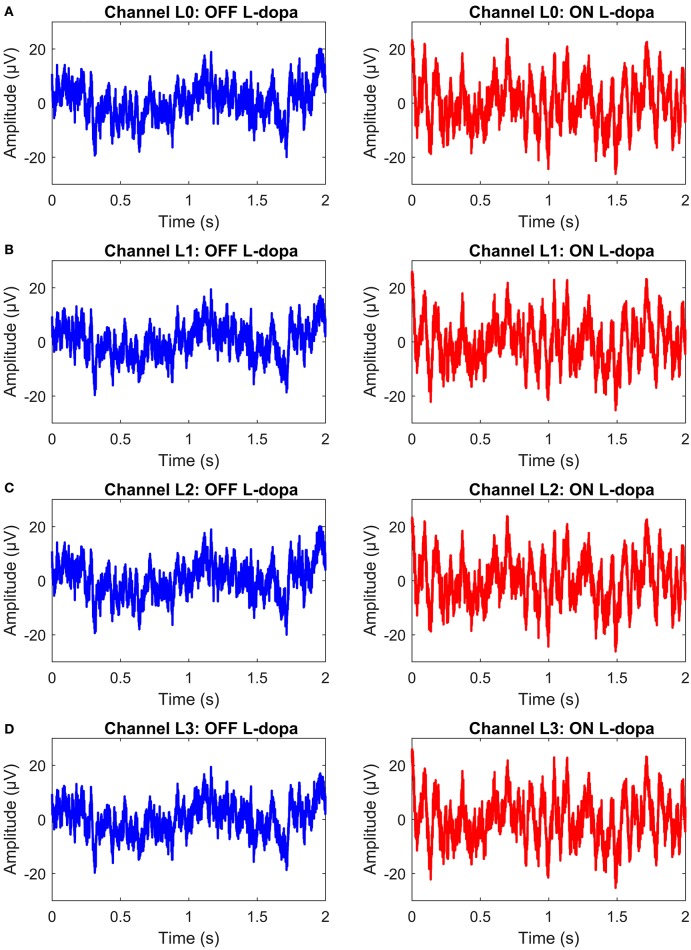
A snapshot of OFF and ON L-dopa recordings (representing PD and non-PD LFP recordings) of the left DBS lead of dataset A. (A) OFF and ON L-dopa recordings of electrode L0. (B) OFF and ON L-dopa recordings of electrode L1. (C) OFF and ON L-dopa recordings of electrode L2. (D) OFF and ON L-dopa recordings of electrode L3.